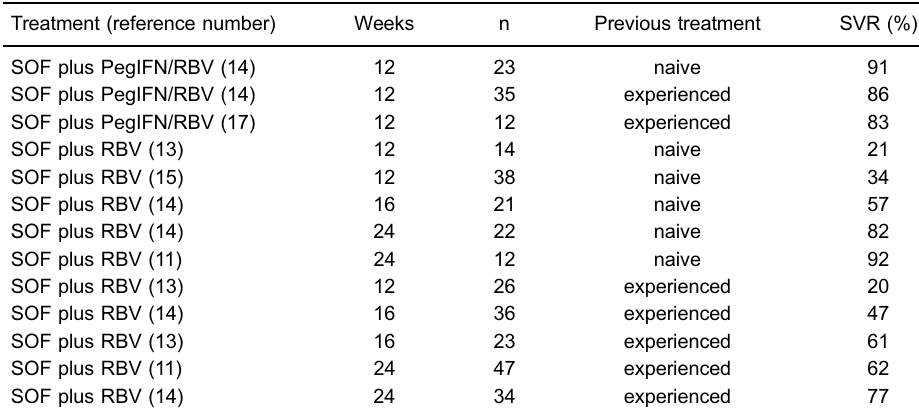
Table 3. Summary of sustained virological response (SVR) rates in cirrhotic patients with hepatitis C virus (HCV) genotype 3 infection treated with sofosbuvir (SOF) plus pegylated interferon(PegIFN)/ribavirin(RBV) or SOF plus